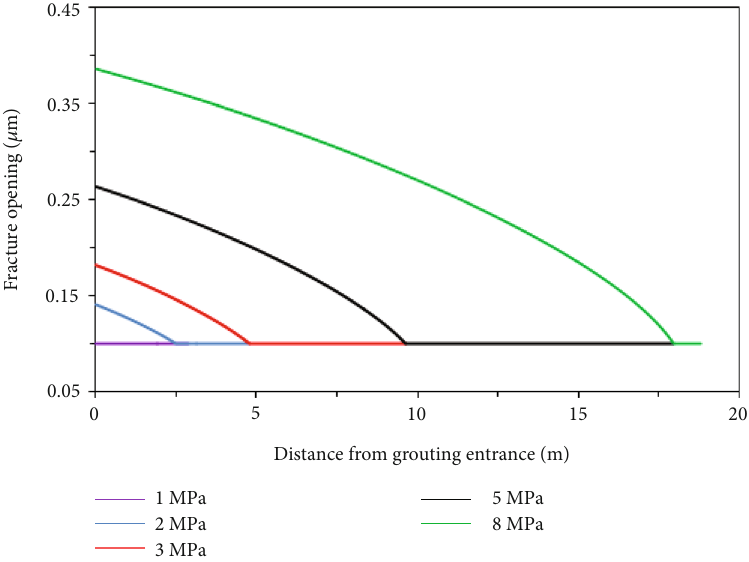
Figure 15: Curve of fracture opening vs. distance for di ff erent grouting